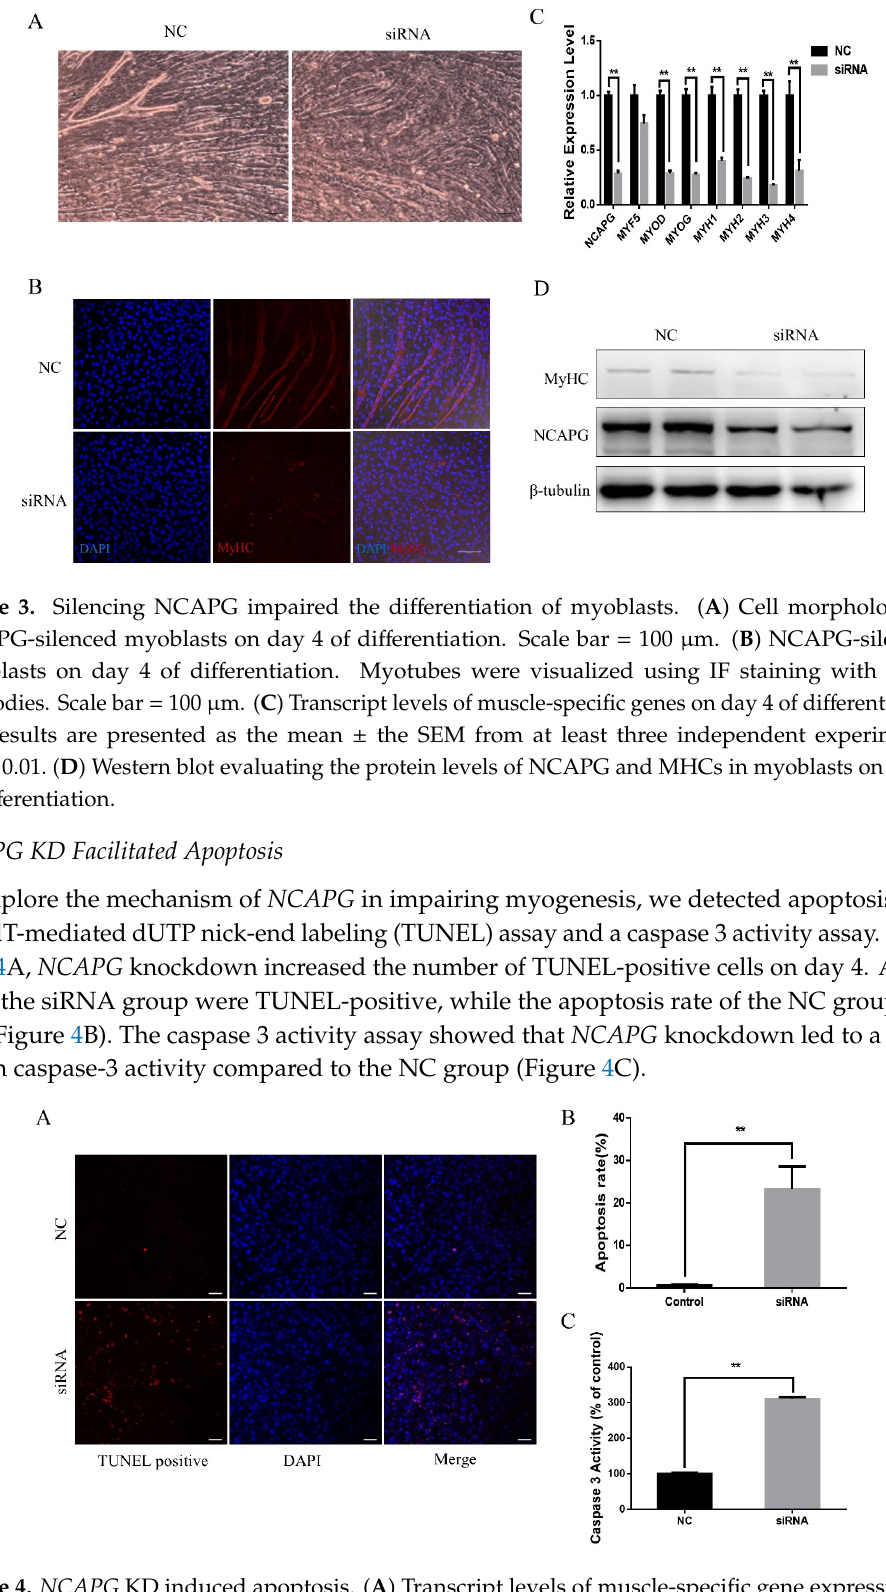
Figure 4. NCAPG KD induced apoptosis. ( A ) Transcript levels of muscle-specific gene expression in AP-1 subunits (FOSL2) in depleted myoblasts. ( B , C ) Transcript levels of muscle-specific gene expression in AP-1 subunits (JUNB) in depleted myoblasts. The results are presented as the mean ± the SEM from at least three independent experiments, * p < 0.05, ** p <